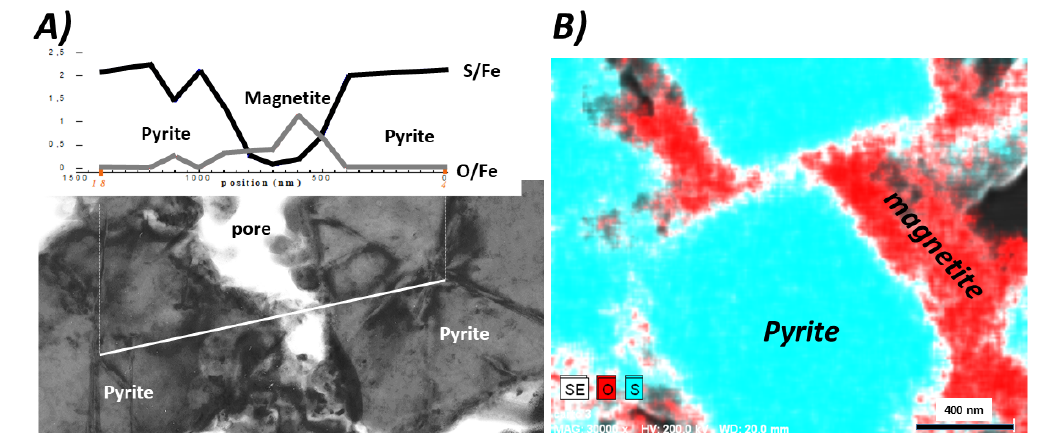
Figure 10. Transmitted electronic microscopy (TEM) microphotograph of pyrite from the FIB section (see Figure 9). ( A ) EDX profile between two pyrite grains. In between, iron oxide was detected. This was presumably magnetite. ( B ) EDX map of oxygen and sulfide. The pyrite grain was not oxidized, and iron oxide—presumably magnetite—framed the pyrite.